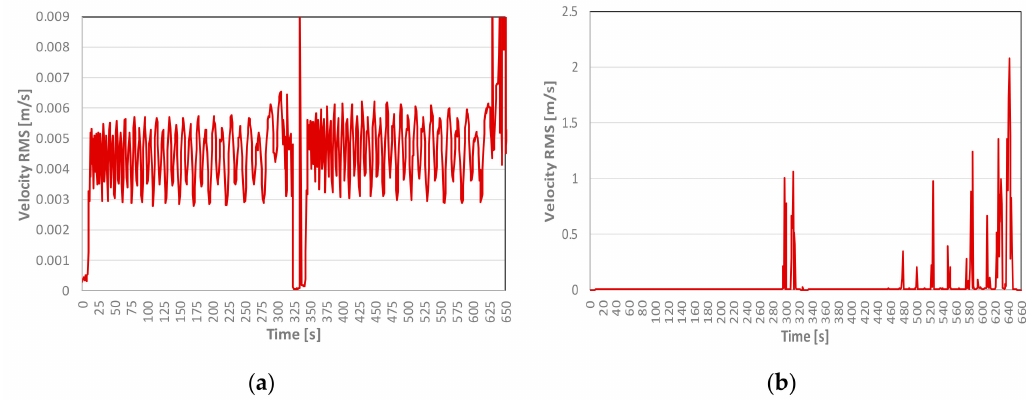
Figure 9. Vibrations amplitude on PVD AlTiN coated inserts for the group of tests corresponding to ( a ) PH7930-L1 and ( b ) PH7930-L2 cutting tests.